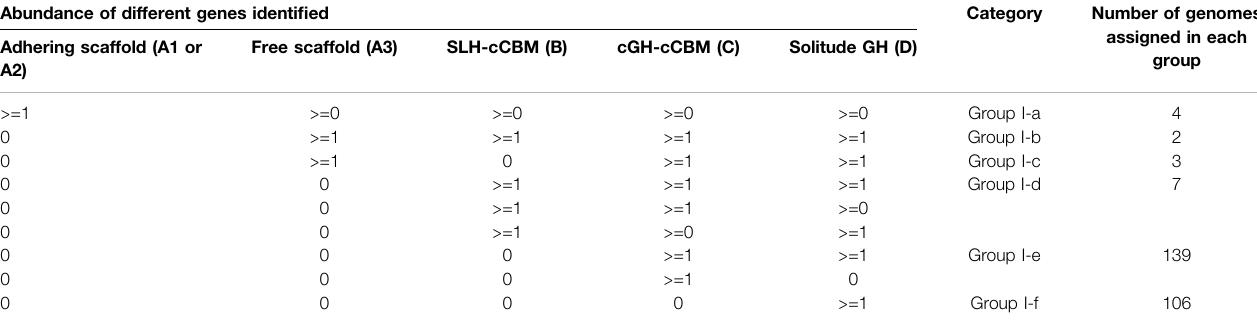
TABLE 2 | Genotype-based categorization of genomes annotated with both exoglucanase and endoglucanase GH modules. The cellulose-binding CBM module was referred to as “ cCBM, ” for example, the SLH-cCBM genes are genes harboring both the SLH module and the cellulose-binding CBM module; the exo/endoglucanase GH modules were referred to as “ cGH ” modules in this